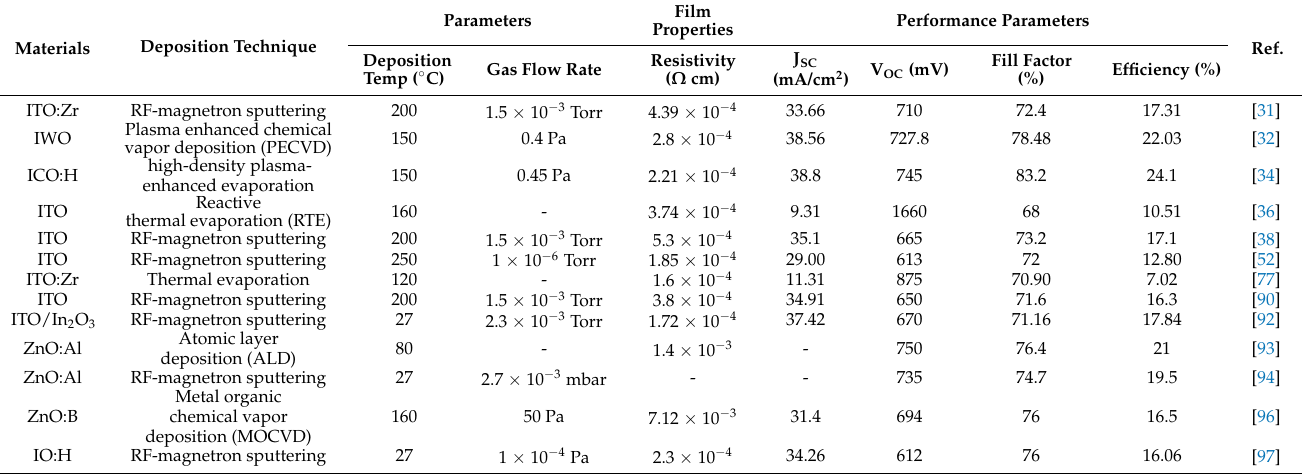
Table 2. List of TCO films and deposition techniques with parameters, films properties, and